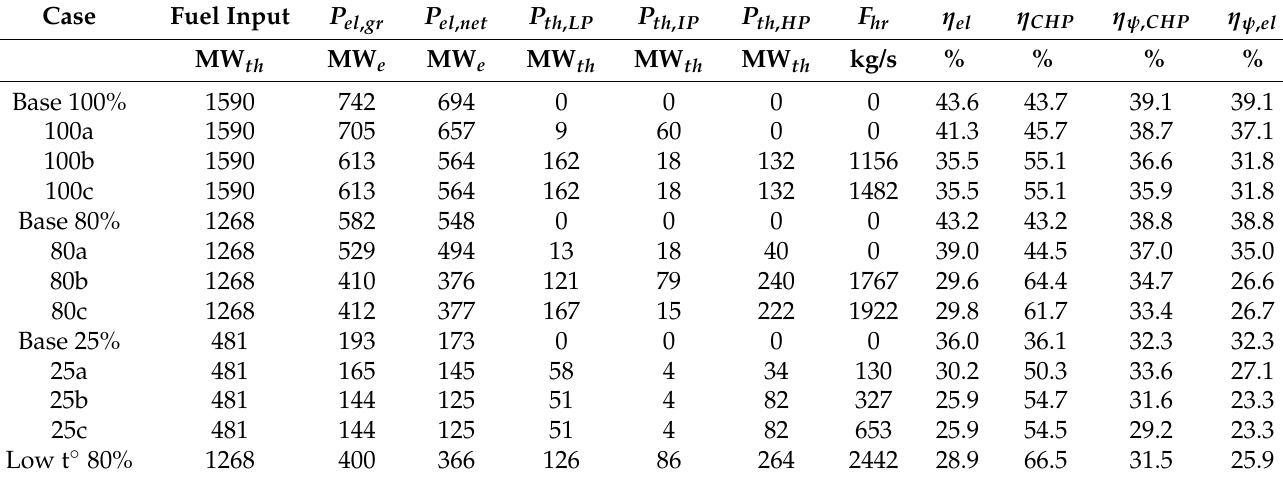
Table 6. Simulation results for the 13 cases defined in Table